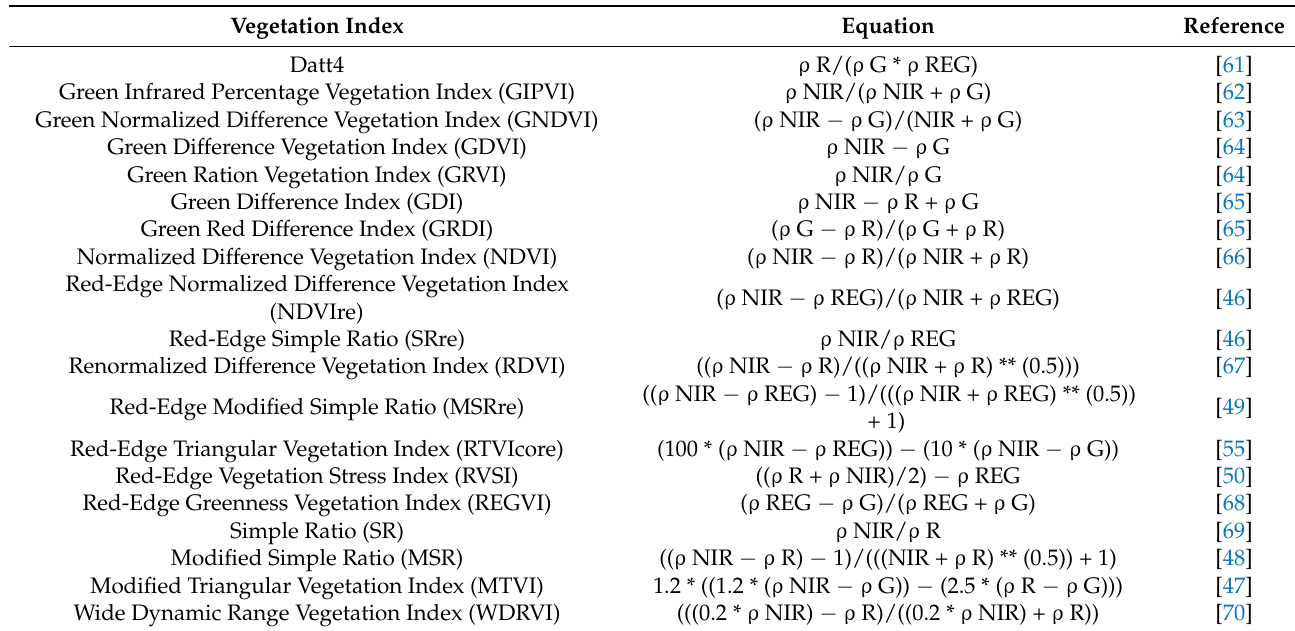
Table 1. Descriptions and formulas of multispectral UAS derived VIs used in this study. The ρ R refers to the reflectance of the red band, ρ G refers to the reflectance of the green band, ρ REG refers to the reflectance of the red edge, and ρ NIR refers to the reflectance of the